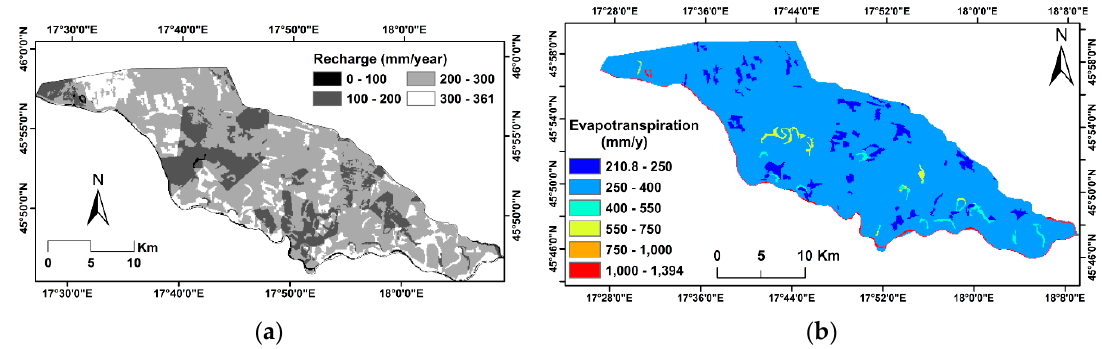
Figure 4. Spatial distribution of simulated mean water balance components: ( a ) Groundwater recharge; ( b ) actual evapotranspiration.